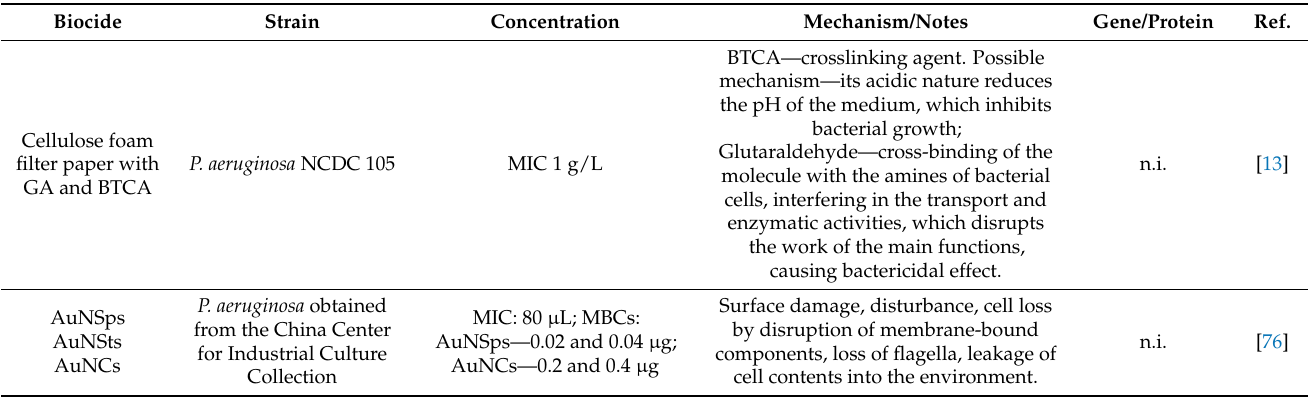
Table 2. Biocides and their impact on Pseudomonas